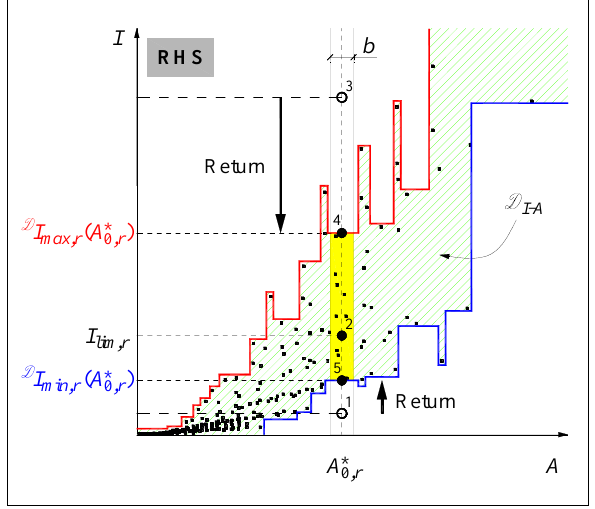
Fig. 12. Binary-bared search: return to the admissible